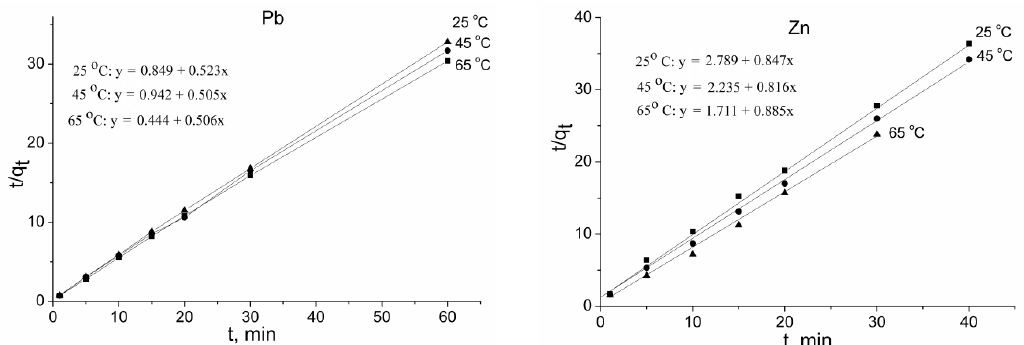
Figure A1. Pseudo-second-order kinetics for Pb 2+ and Zn 2+ ion adsorption on titanium phosphate (the initial concentration of metal ions was 1 mmol·L −1 ).